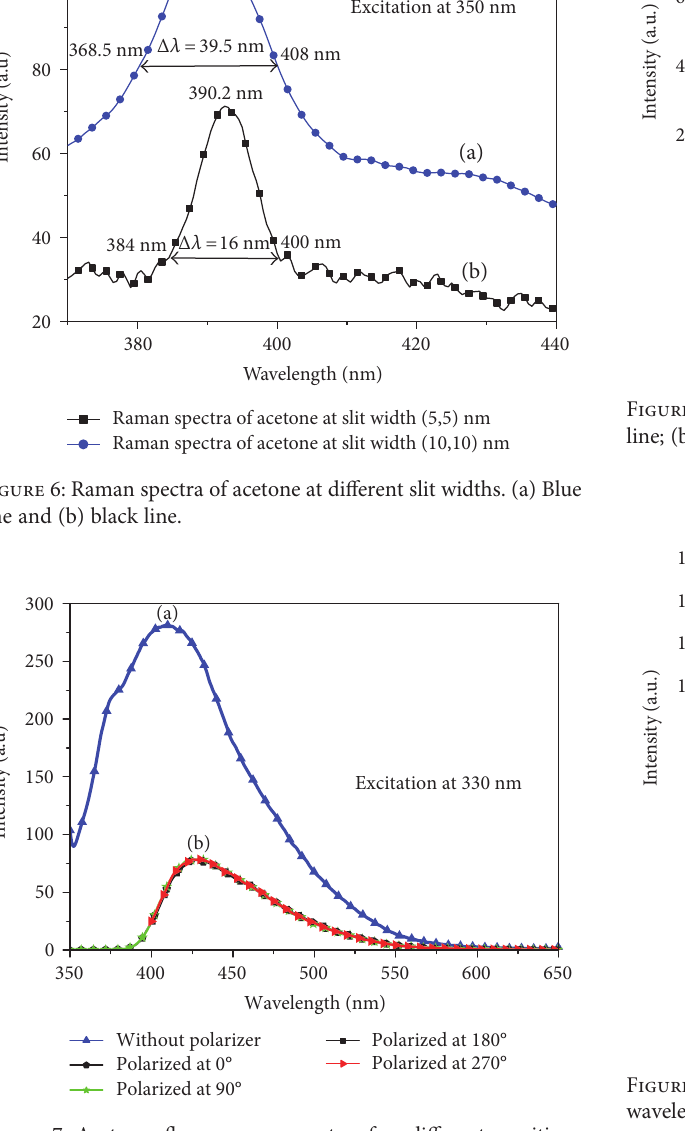
Figure 7: Acetone fl uorescence spectra for di ff erent positions of polarizer.